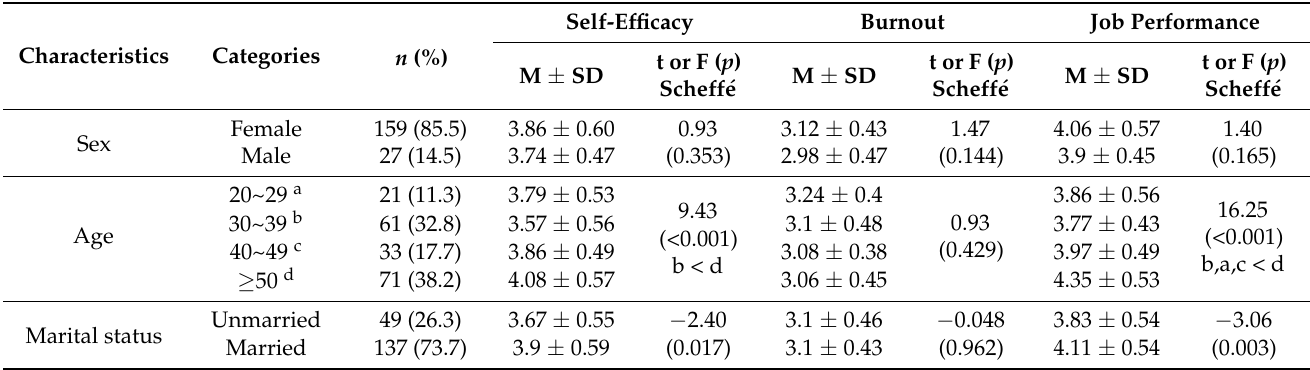
Table 1. Differences in self-efficacy, burnout, and job performance according to general characteristics ( n =